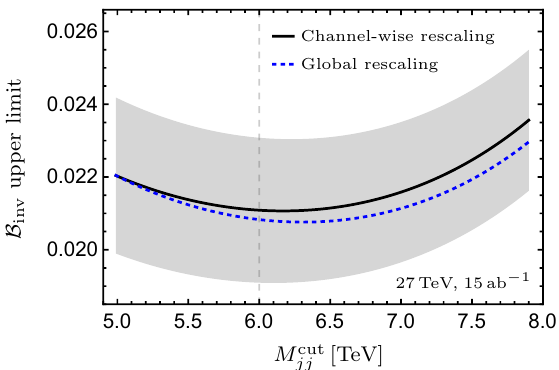
Figure 6 . Upper limit on the invisible branching ratio of the SM Higgs boson as a function of the M jj -cut for the 27 TeV HE-LHC. Otherwise cuts from table 1 are applied. We show the limit using a channel-wise (black, solid) and global (blue, dotted) rescaling of the background prediction, see text for details. For illustration, the grey band shows the respective shift of the solid black line resulting from a 10 % variation of the background cross